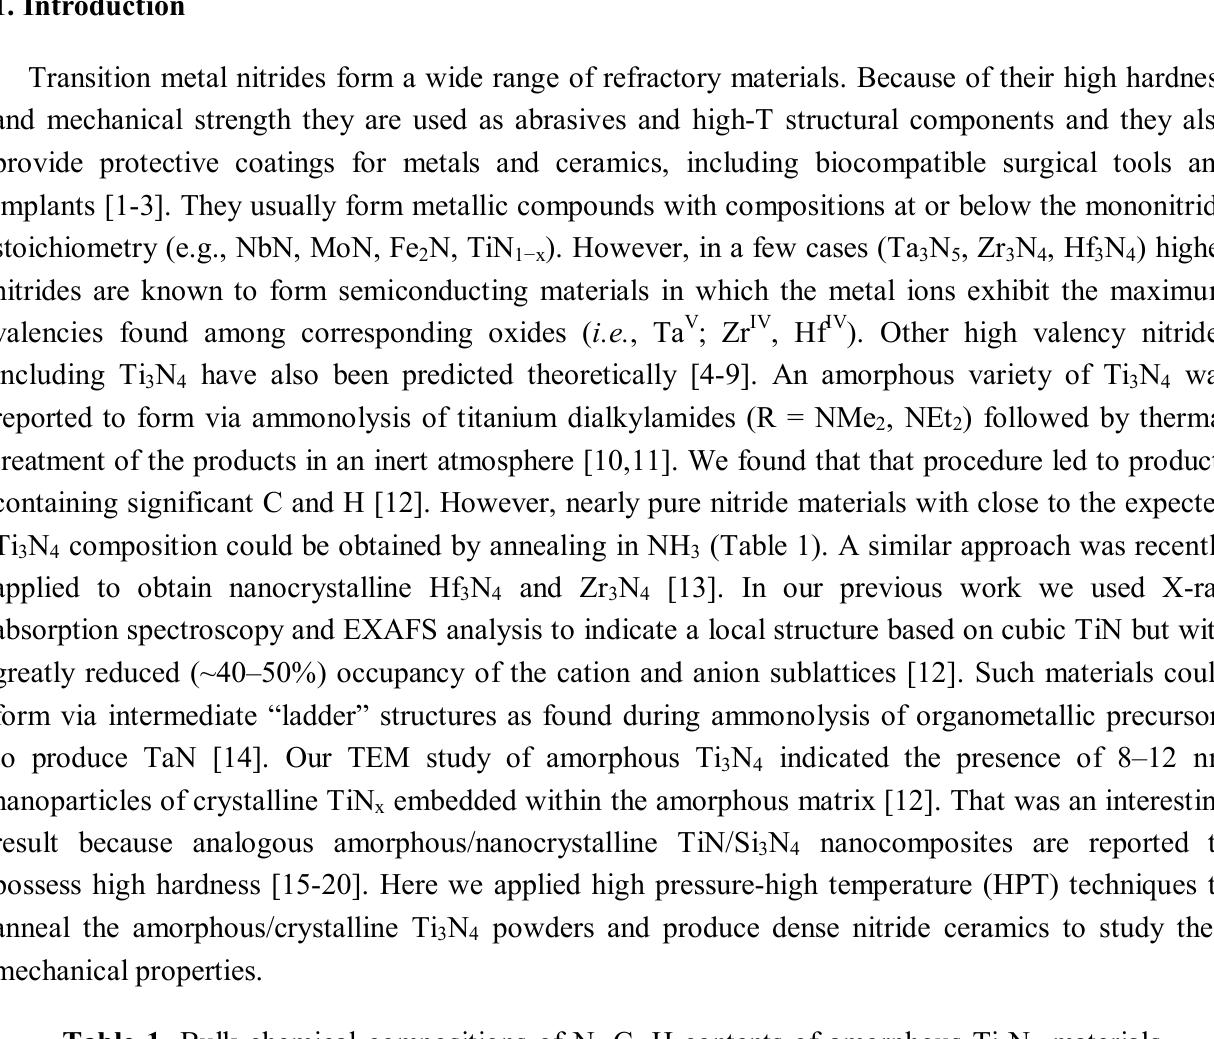
Table 1. Bulk chemical compositions of N, C, H contents of amorphous Ti